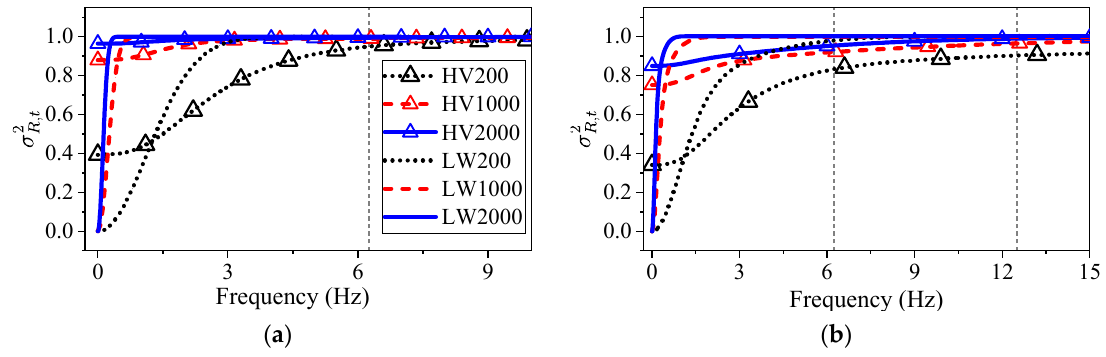
R calculated using HV and LW spectral coherence models: ( a ) inter-event Figure 4. Variances of Figure 4. Variances of R l calculated using HV and LW spectral coherence models: ( a ) inter-event l R and ( b ) loop variance of R . variance of variance of R l and ( b ) loop variance of R l l l